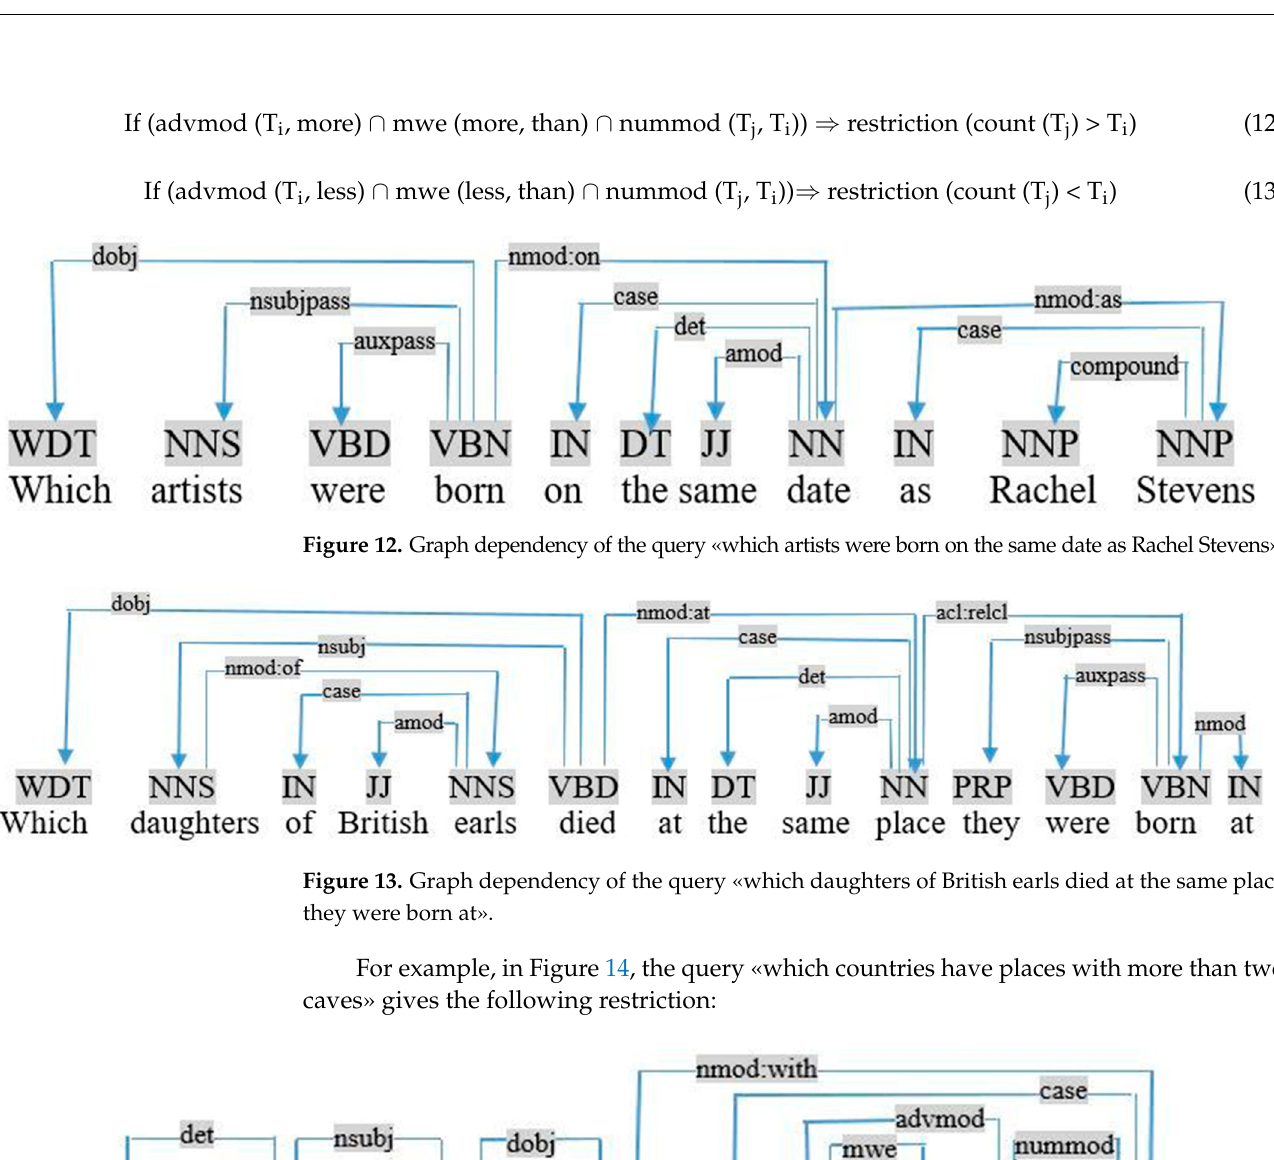
Figure 15. Graph dependency of the query «which U.S. state has the highest population density». This rule identifies the relationship between the superlative adjective Tj and the noun Ti. Consider the previous query, this rule is used to generate the following restriction: Relation < density, unknown, highest > ∩ Pos (highest) = JJS  restriction (density, Sup, highest) (ii) most/least + adjective, such as “most deep” in the query «where is the most deep point in the ocean», as shown in Figure 16. In this case, we applied the following rule: If (advmod (T i , most/least) ∩ Relation < T j , unknown, T i > ∩ Pos (Ti) = JJ)  restriction (T j , Sup, most/least-T i )